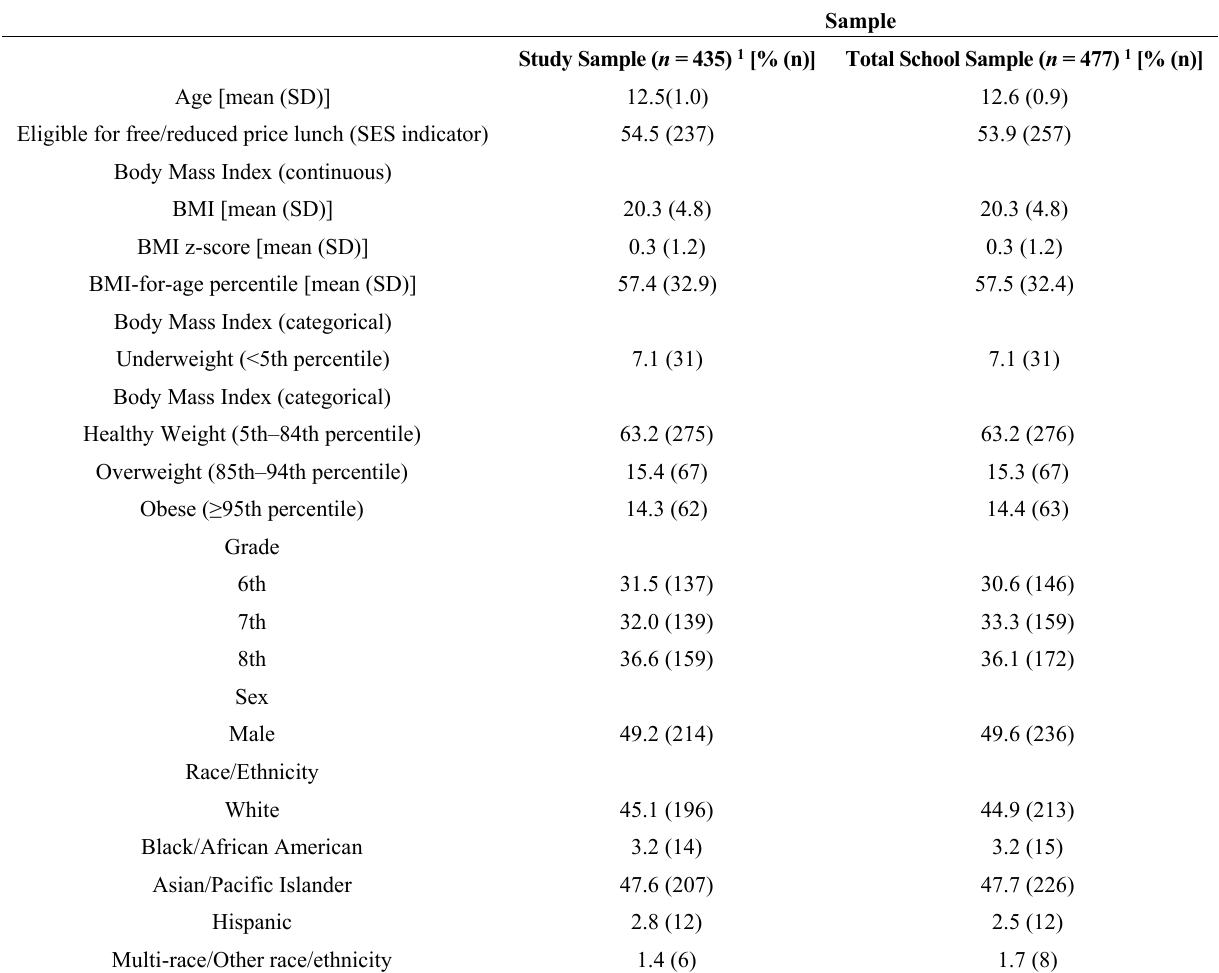
Table 1. Study Sample Characteristics.